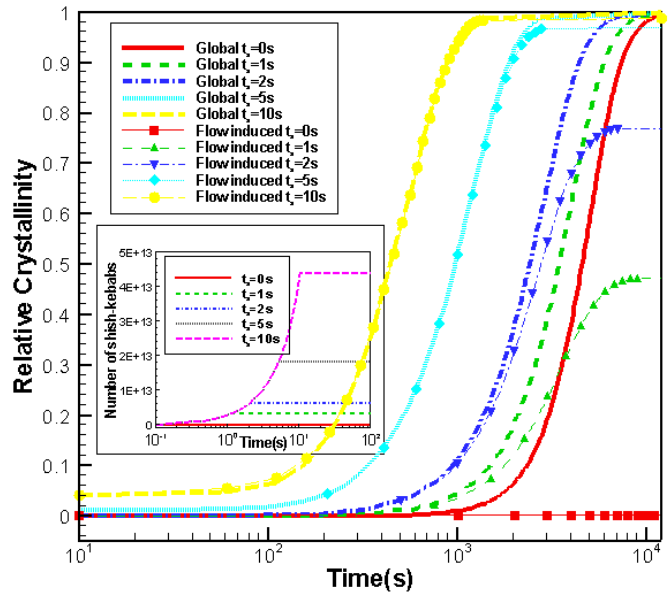
Figure 8. Relative crystallinity comparison with different shear time. 2017 , 7 , 51